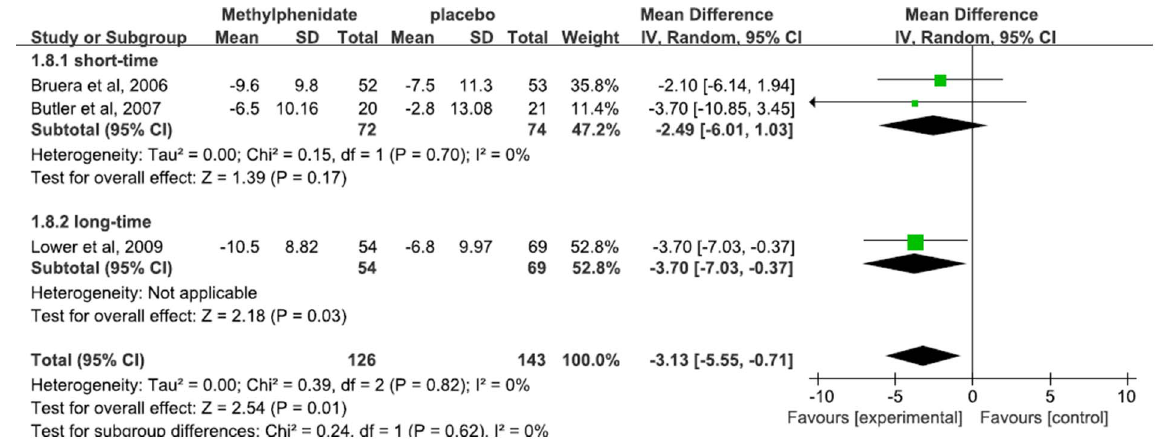
Figure 3. Effects of Methylphenidate with different treatment duration on Cancer-Related Fatigue.